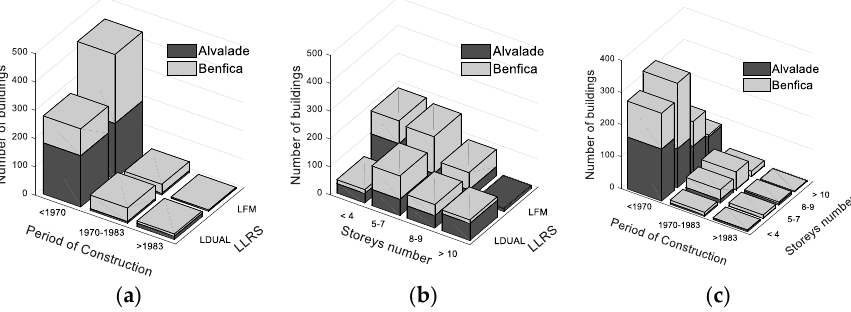
Figure 7. Distribution of buildings as a function of: ( a ) lateral load resisting system (LLRS) and period of construction, ( b ) LLRS and number of storeys and ( c ) period of construction and number of storeys.